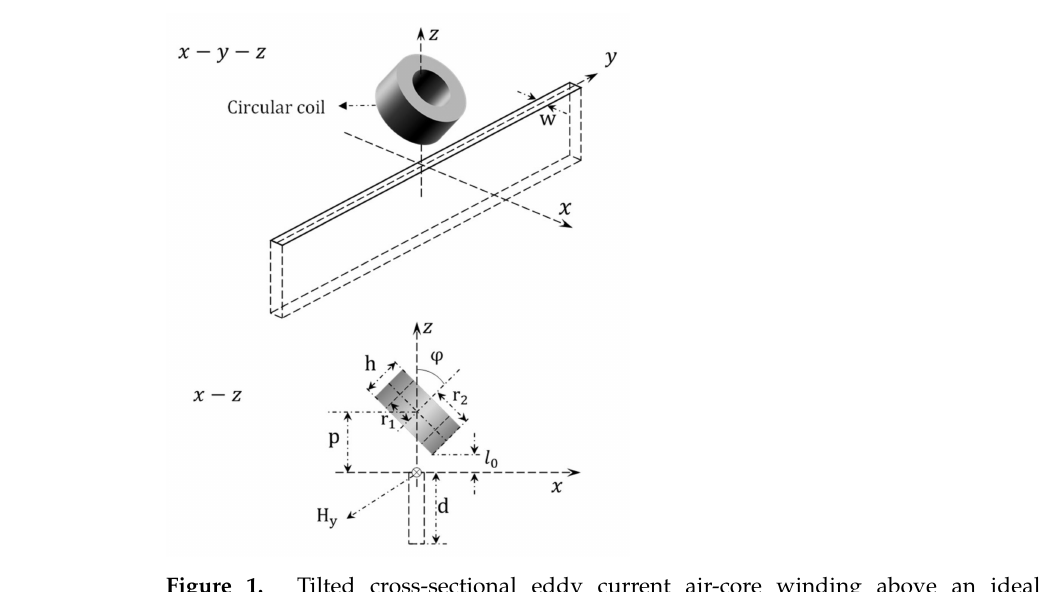
Figure 1. Tilted cross-sectional eddy current air-core winding above an ideal notch of conductive half-space.